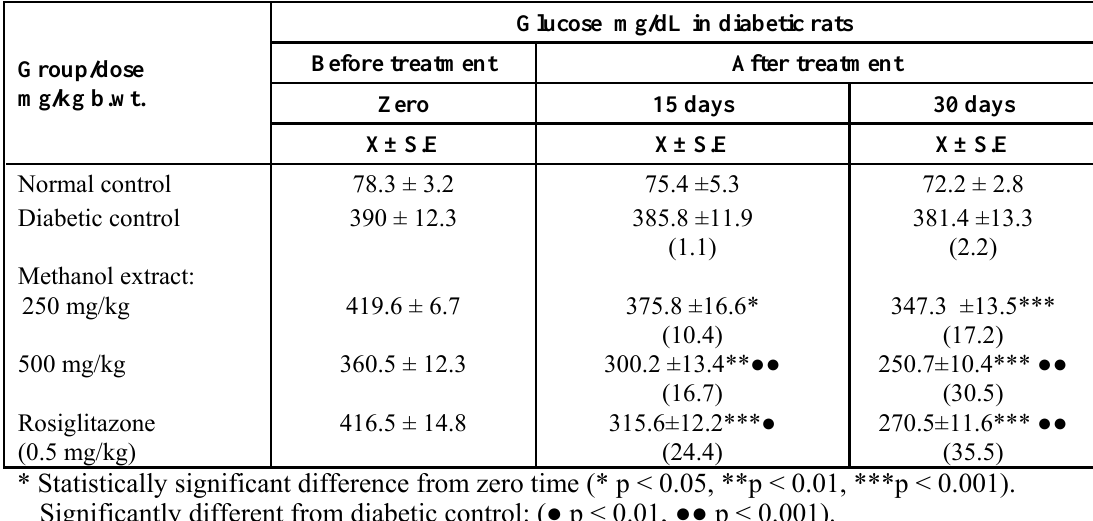
Table 2. Effect of oral administration of 80 % aqueous methanol extract of O. speciosa